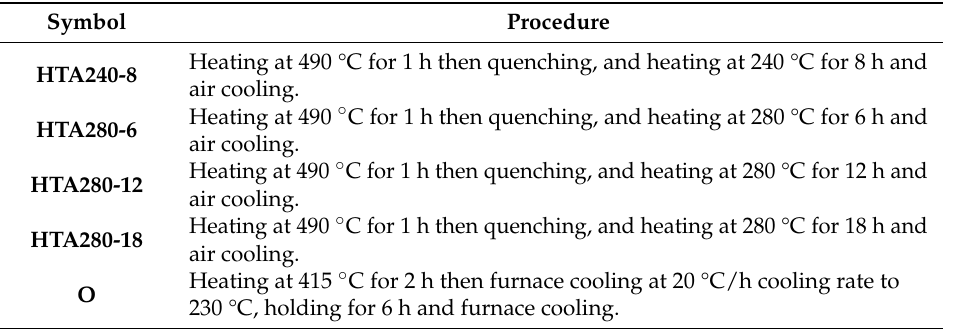
Table 2. Experimental conditions and specimen